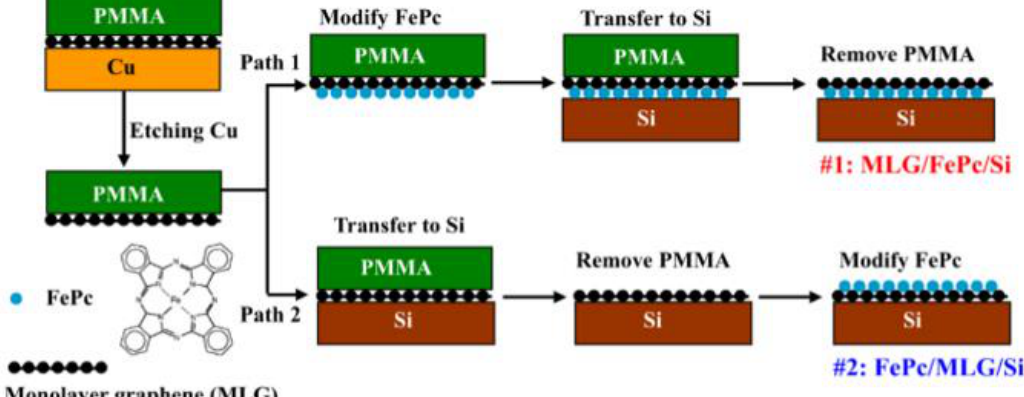
Figure 3. Schematic of the fabrication of monolayer graphene (MLG) / FePc / Si and FePc / MLG / Si, adapted from ref [47] Copyright 2020 Elsevier.